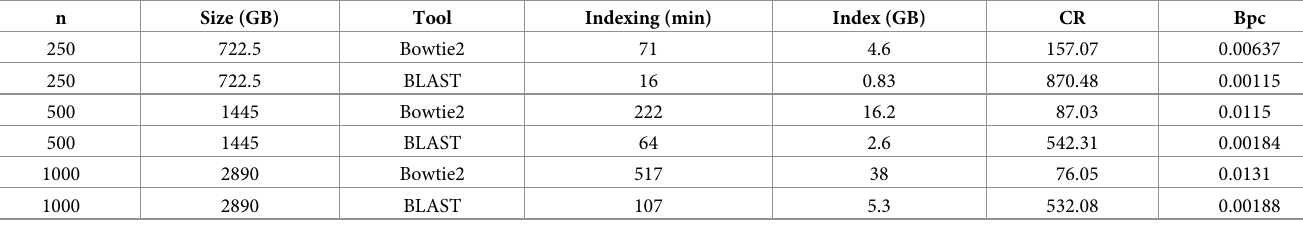
Secondly, we test the scalability of Distributed RLZ compression with different pan-genome sizes ranging from n = 250 to n = 1000 haploid genomes. The compressed size equals the ker- nel size which is indexed in the following experiments. Table 2 shows the compression result with accumulating pan-genome size. The total runtime with n = 250 is 326 minutes, 678 min- utes with n = 500, 1049 minutes with n = 750, and 1421 minutes with n = 1000. Compression ratios are 258:1, 208:1, 187.4:1 and 176.8:1 respectively. Bytes per character (Bpc) is simply the inverse of the compression ratio. Third, we construct complete indexes for compressed pan-genomes of sizes n = 500 and n = 1000 compatible with Bowtie2 and BLAST (Table 3). Here, the indexing time includes also the distributed kernelization step using RLZ compression from the DRLZ step. The index size includes the index generated by the standard tool and the data generated by the CHIC. Bow- tie2 index is constructed from a single kernel sequence concatenated from the chromosomal kernels on a single node. The BLAST index is constructed from chromosomal kernels on 22 nodes and the BLAST database is concatenated from the chromosomal indexes with blas- tdb_aliastool due to its limited input size (4 GB). Fig 5 summarizes the DRLZ compres- sion and distributed indexing execution times with different pan-genome sizes. Then n = 250 subset was indexed in 71 minutes with Bowtie2 and in 16 minutes with BLAST with compres- sion ratios of 157:1 and 870:1 respectively. The n = 500 subset was indexed in 222 minutes with Bowtie2 and in 64 minutes with BLAST with compression ratios of 87:1 and 542:1 respec- tively. The n = 1000 subset was indexed in 517 minutes with Bowtie2 and in 107 minutes with Table 3. Building a complete hybrid-index for a human pan-genome using distributed